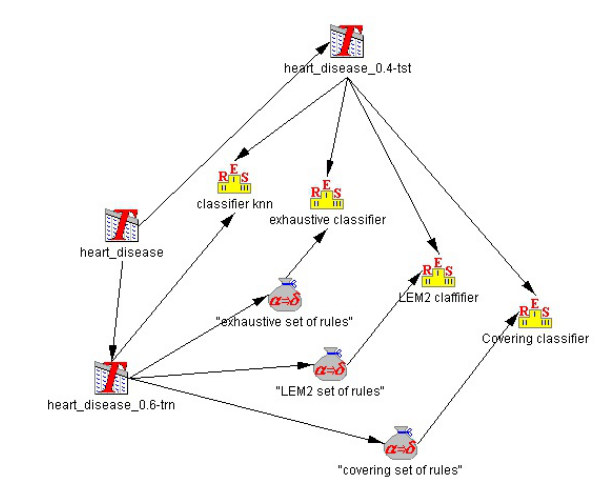
Figure 2. Considering Train and Test with split ratio 0.4 for Statlog (Heart) Data Set (270 objects, 14 attributes) [3], the Training system has 162 objects, the test system 108. Exemplary classification result; in case of knn we have total and balanced accuracy = 0.833, coverage = 1; in case of an exhaustive classifier we have total and balanced accuracy = 0.824, coverage = 1, number _ of _ rules = 2588; in case of an LEM2 classifier we have total accuracy = 0.887, balanced accuracy = 0.871, coverage = 0.491, number _ of _ rules = 65; in case of a Covering classifier we have total accuracy = 0.554, balanced accuracy = 0.56, coverage